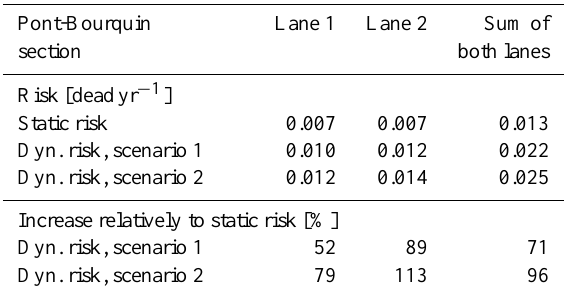
Table B2. Simulation risk results of Pont-Bourquin section. Three